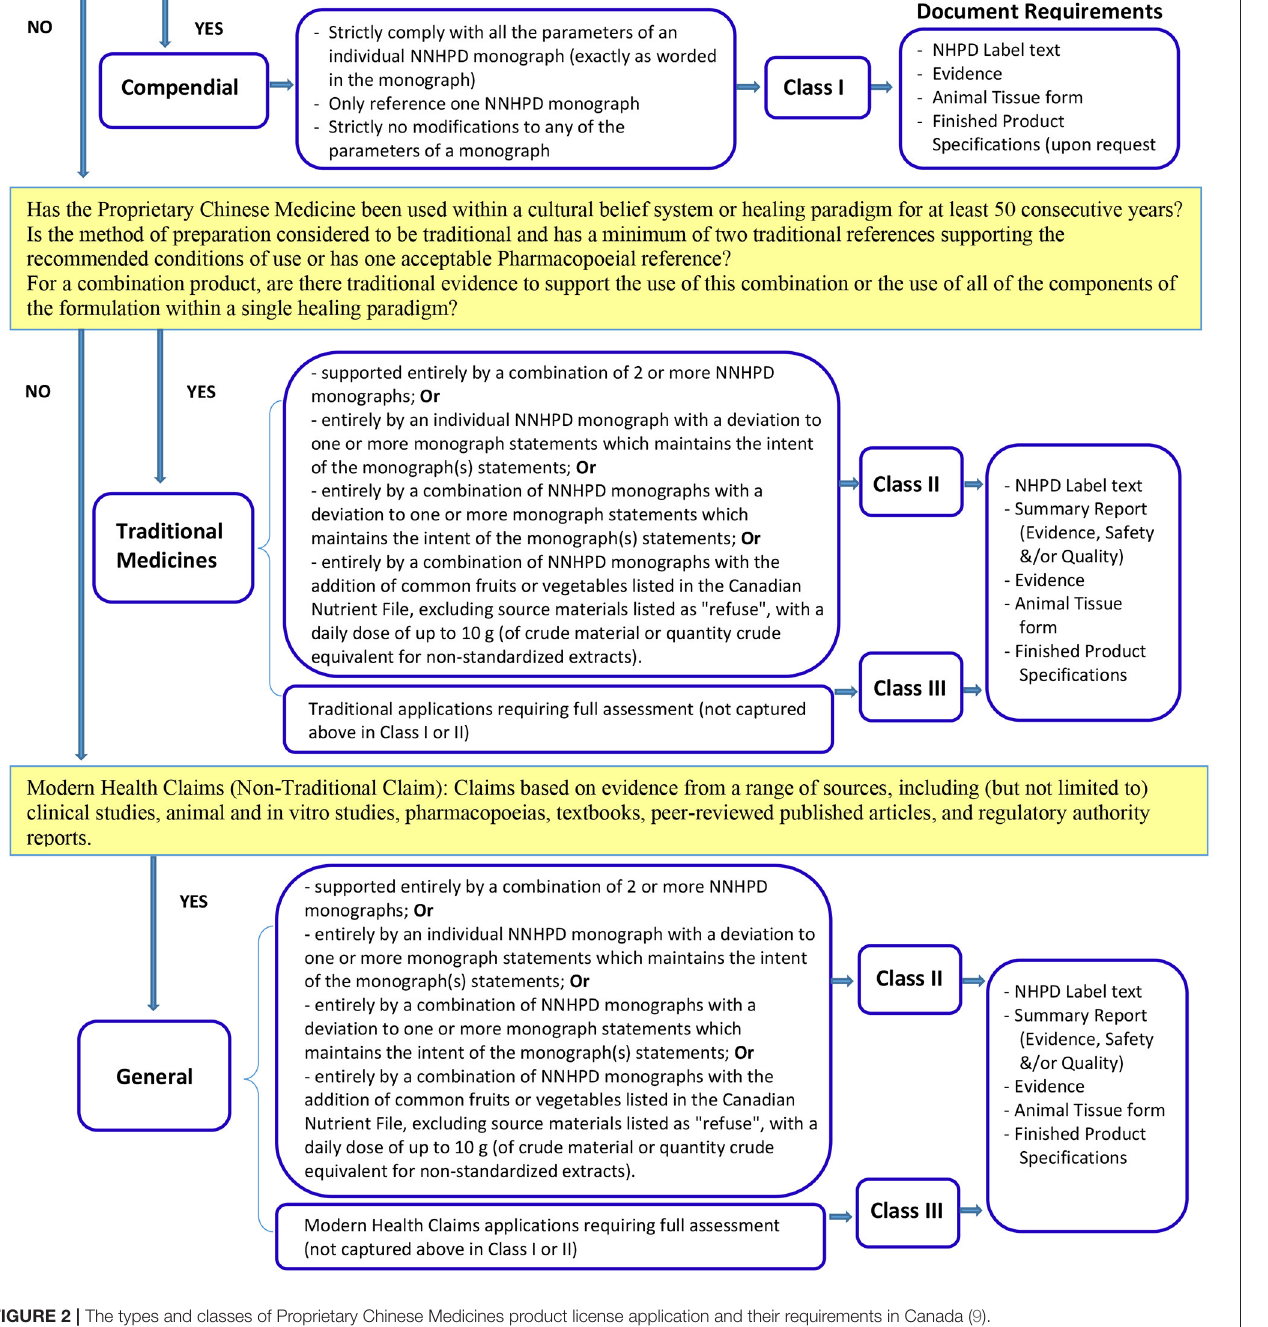
FIGURE 2 | The types and classes of Proprietary Chinese Medicines product license application and their requirements in Canada